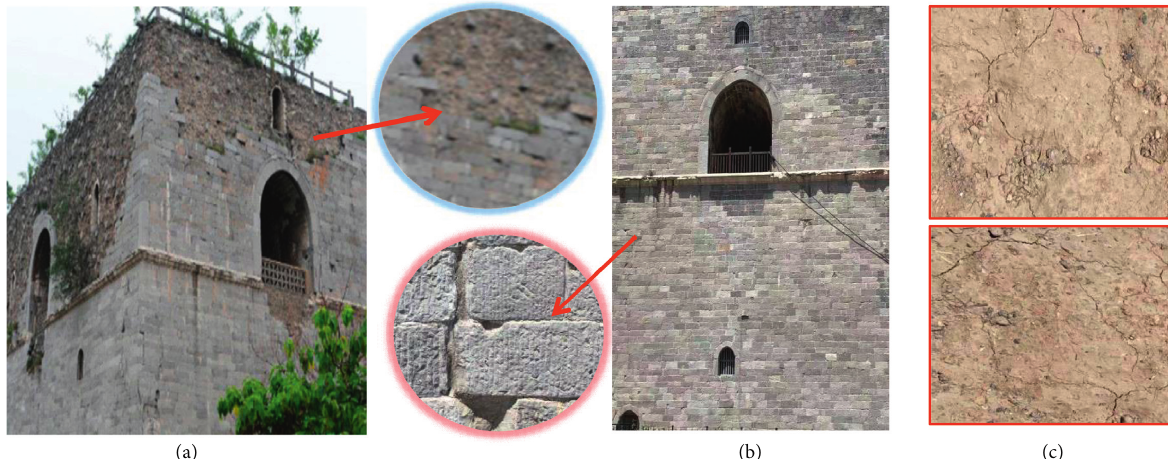
Figure 1: Condition of the Wang-Jing tower and foundation soil. (a) Before the repair. (b) After the repair. (c) Crack phenomenon of foundation soil.